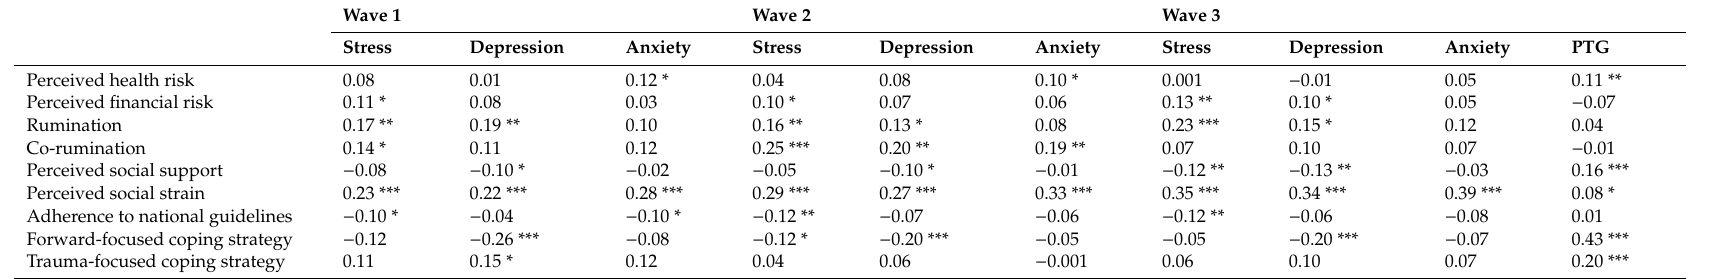
Table 7. Regression of Mental Health Outcomes on Psychosocial and Behavioral